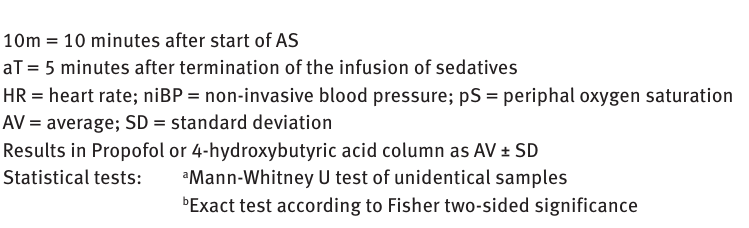
Legend table 5:bS = before the start of analgosedation (AS) 10m = 10 minutes after start of AS aT = 5 minutes after termination of the infusion of sedatives HR = heart rate; niBP = non-invasive blood pressure; pS = periphal oxygen saturation AV = average; SD = standard deviation Results in Propofol or 4-hydroxybutyric acid column as AV ±